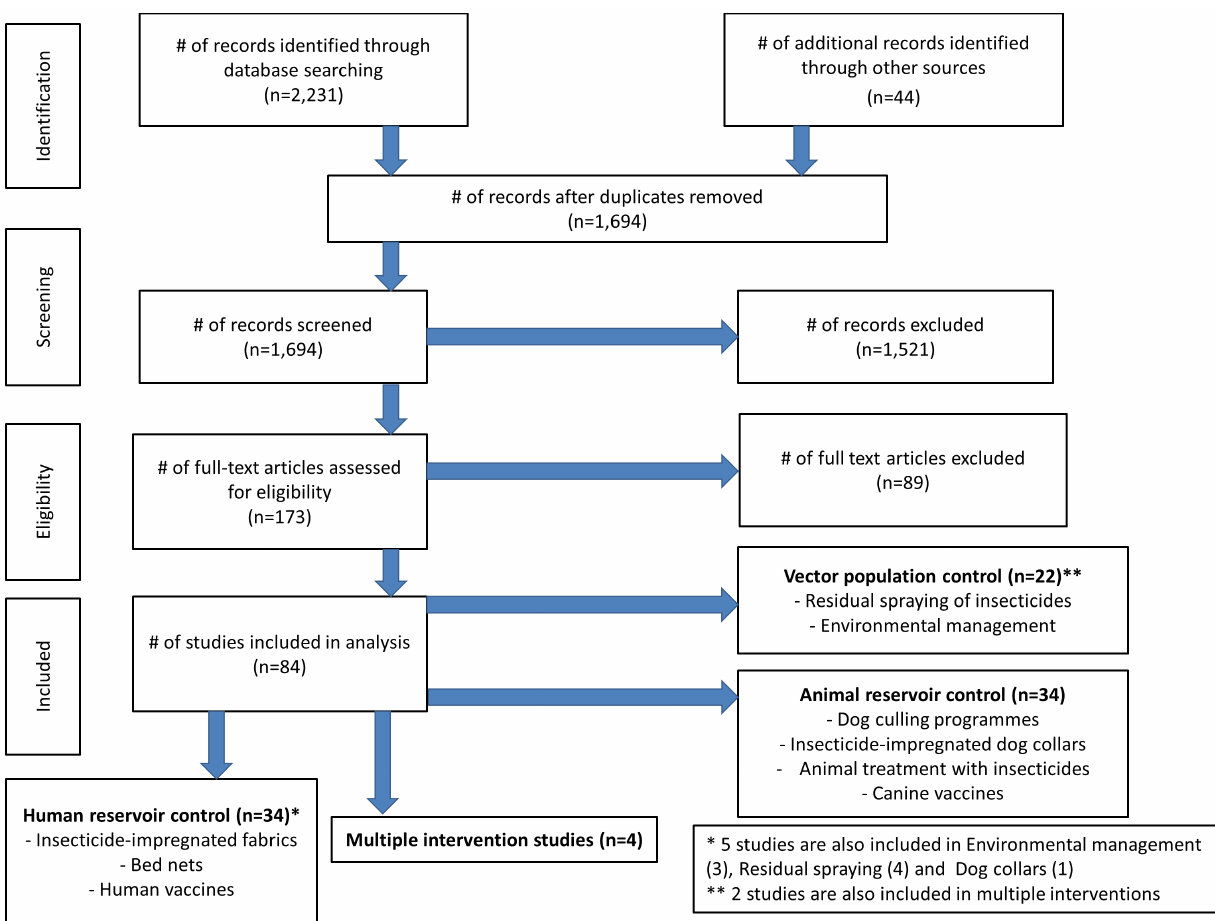
Figure 2. PRISMA flow chart of included studies. PRISMA flow chart documenting numbers of studies retrieved, included and excluded at each stage of the literature search.